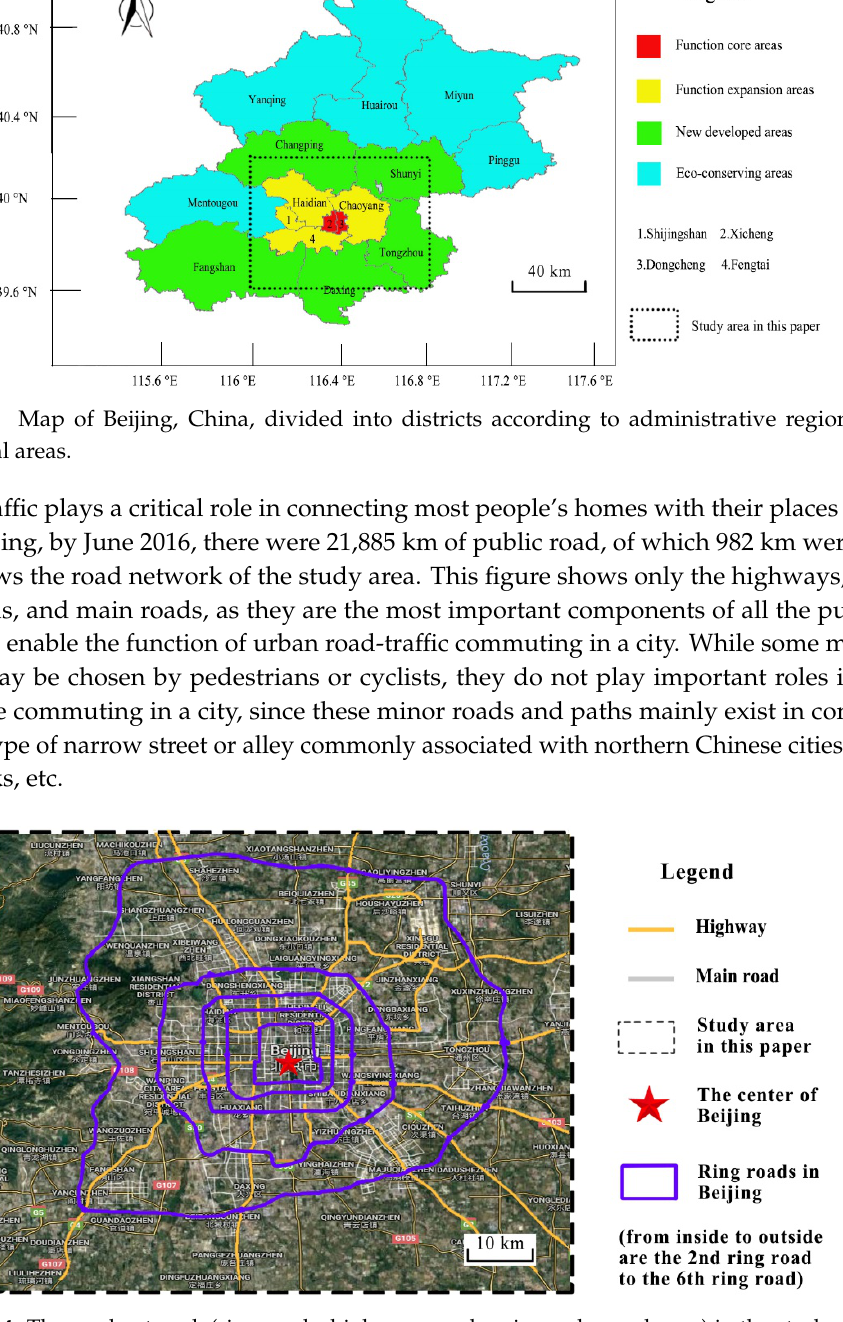
Figure 4. The road network (ring roads, highways , and main roads are shown) in the study